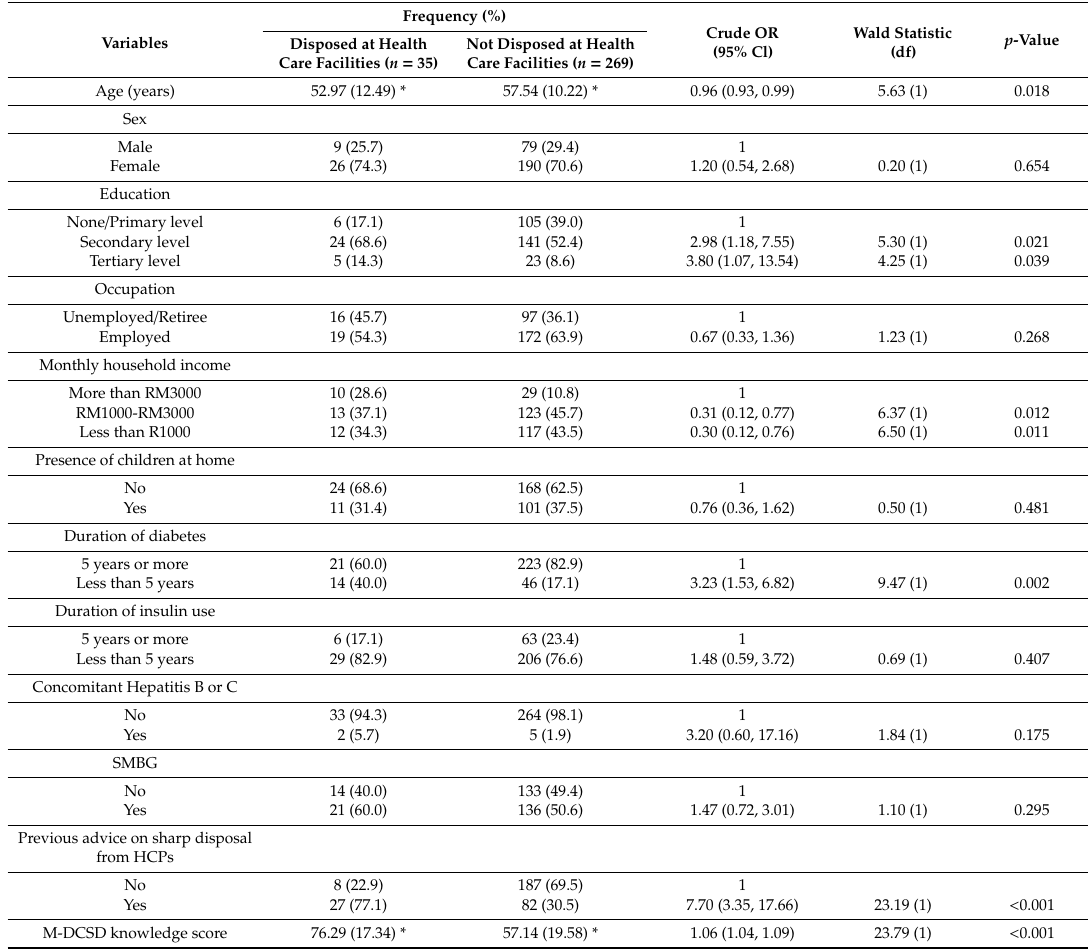
Table 4. Factors contributing to sharp waste disposal at health care facility among Type 2 diabetic patients, using simple logistic regression (n = 304).